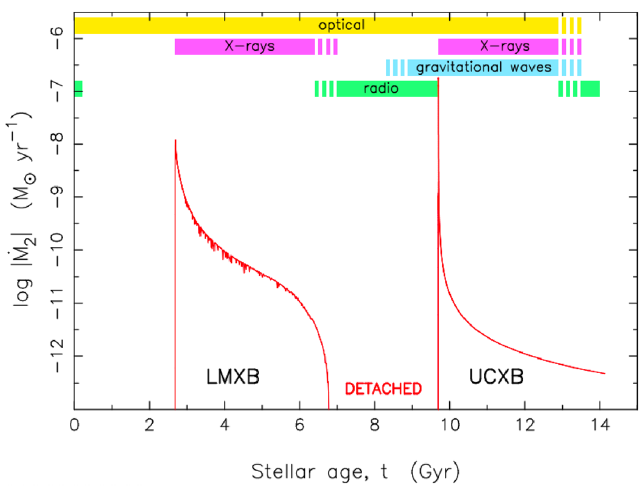
Fig. 8 Evolutionary sequence showing how ultra-compact X-ray binaries (prime LISA source candidates) are formed from merging NS ? WD binaries, descending from LMXBs. Plotted here is mass-transfer rate of the donor star as a function of stellar age. The initial MS star ? NS binary has components of 1 : 40 M (cid:3) and 1 : 30 M (cid:3) , respectively. The system evolves through two observable stages of mass transfer: an LMXB for 4 Gyr, followed by a detached phase lasting about 3 Gyr where the system is detectable as a radio millisecond pulsar orbiting the helium WD remnant of the donor star, until GW radiation brings the system into contact again, producing a UCXB. The colour bars indicate detectability in different regimes resulting in synergies between LISA and EM detectors. Image reproduced with permission from Tauris